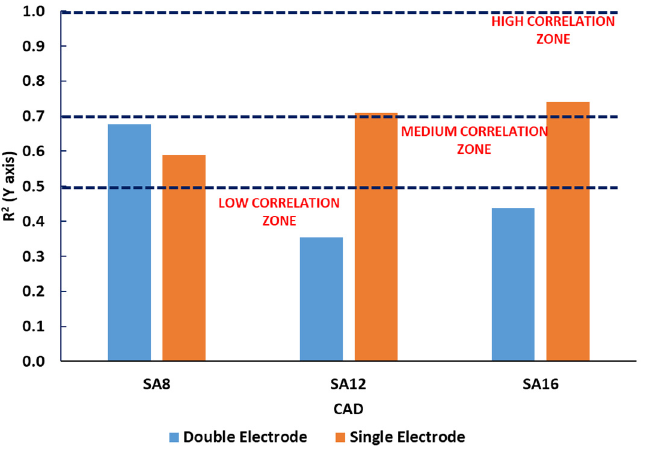
Figure 9. Coefficient of determination R 2 of linear fit between the Y-axis displacement of kernel and flame at CA 5 for the cross-flow orientation for different spark advances and fixed AFR rel (1.15).